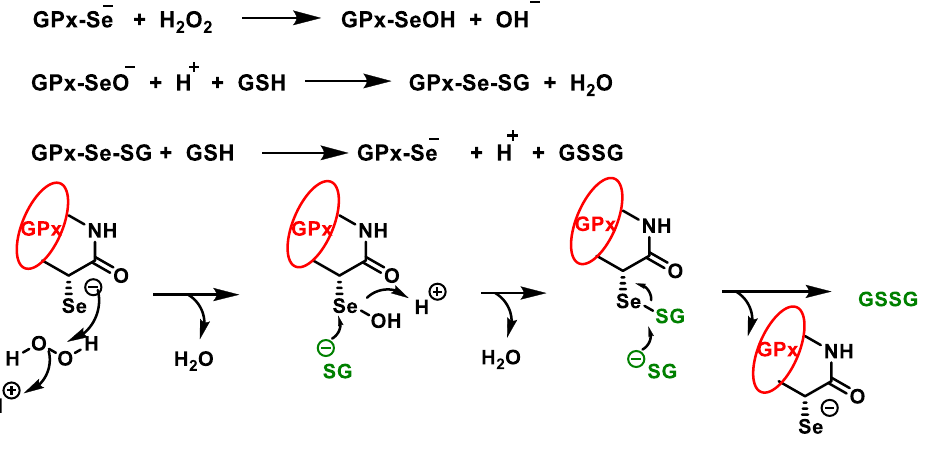
Figure 15. Catalytic cycle of glutathione peroxidase for the reduction of H 2 O 2 .